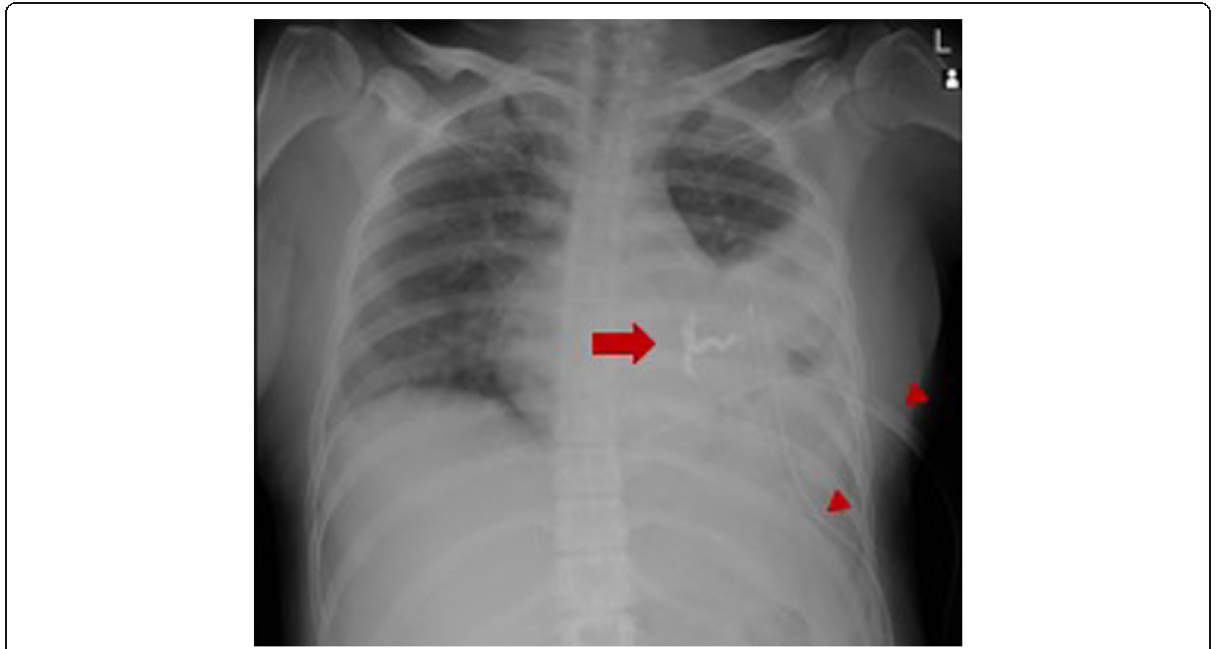
Fig. 1 Chest X-ray imaging at 30 weeks of gestation. Embolization coils (the arrow) and chest tubes (arrowheads) are placed for the pleural hemothorax treatment due to the ruptured arteriovenous